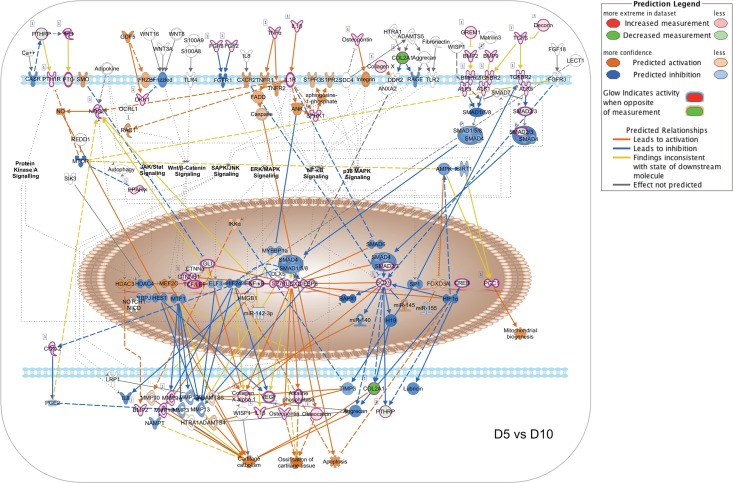
Changes in canonical signaling pathway activity in MC3T3-E1 cells between days 5 and 10.Expression ratios representing the changing abundance of 237 bone-related mRNA species in MC3T3-E1 cells between days 5 and 10 in culture were used to populate the IPA osteoarthritis pathway network and signaling pathway activation state was assessed using the IPA molecular pathway predictor tool. Observed upregulation and downregulation of mRNAs are shown in red and green, respectively, while predicted activation or inhibition of signaling intermediates and pathways are shown in orange and blue.